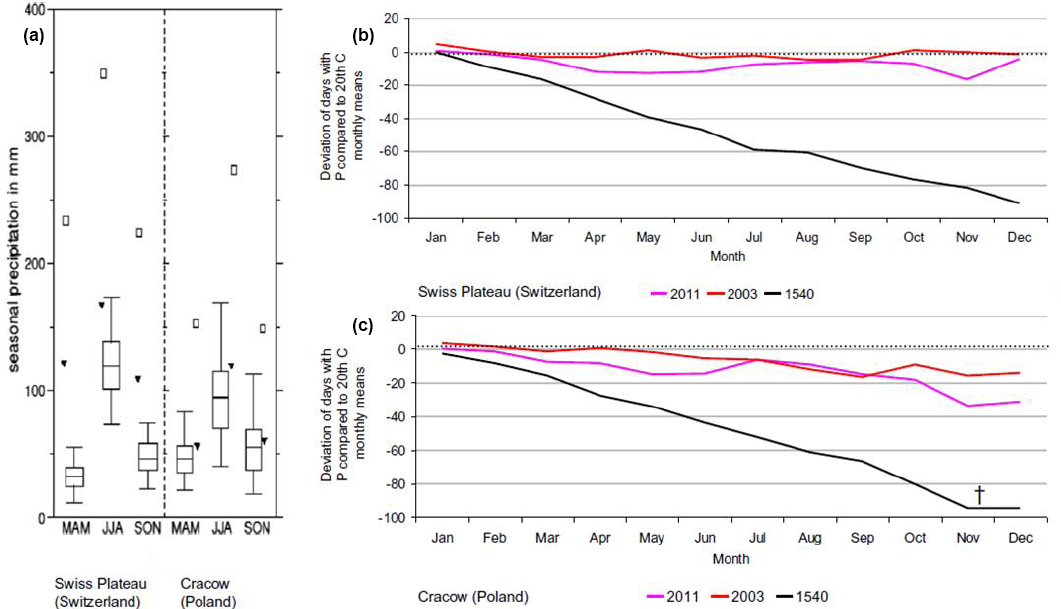
Figure 15. Reconstructed seasonal precipitation amounts for spring, summer and autumn and cumulative deviations of 1540 NPD compared to the 20th century mean, 2011 and 2003. (a) Median, upper and lower quartiles (boxes), 95% uncertainties (whiskers) as well as 50- and 100-year minimum levels (box and triangle) of 20th century data for the Swiss Plateau (northern Switzerland) average (a) and Cracow (b) . (b) compares cumulative deviations of NPD in northern Switzerland in 2011, 2003 and 1540. NPD for 2003 and 2011 is taken from the Federal Office of Meteorology and Climatology, MeteoSwiss (NPD was averaged over the stations of Basel, Lucerne, Schaffhausen and Zürich). Dotted line: 20th century mean of days with precipitation ≥ 1mm. (c) compares cumulative deviations of NPD in Cracow, Poland, in 2011, 2003 and 1540. NPD for 2003 and 2011 is taken from the Center for Poland’s Climate Monitoring. Dotted line: 20th century mean of days with precipitation ≥ 1mm; † date of death of Marcin Biem: 19 November 1540 (Wetter et al.,